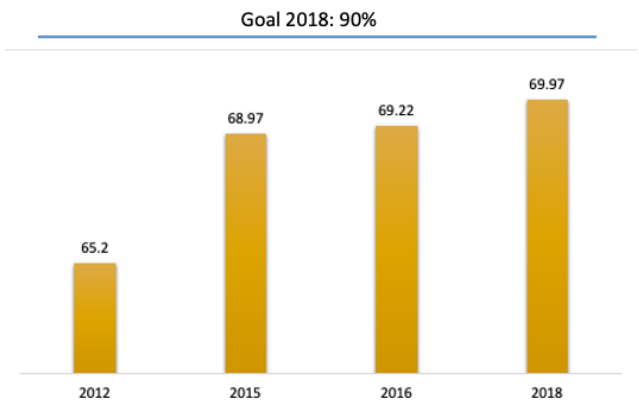
Figure 2. Percentage of a complete supply of drugs, 2012-2018.